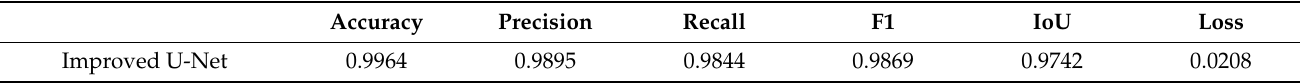
Table 4. Improved U-Net segmentation performance evaluation on the validation